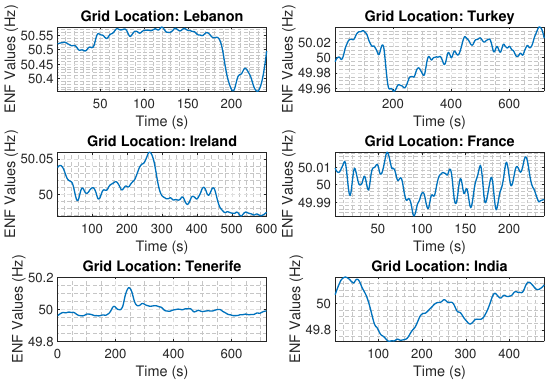
Figure 3. Sample ENF sequences extracted from power recordings from different 50 Hz grid locations.